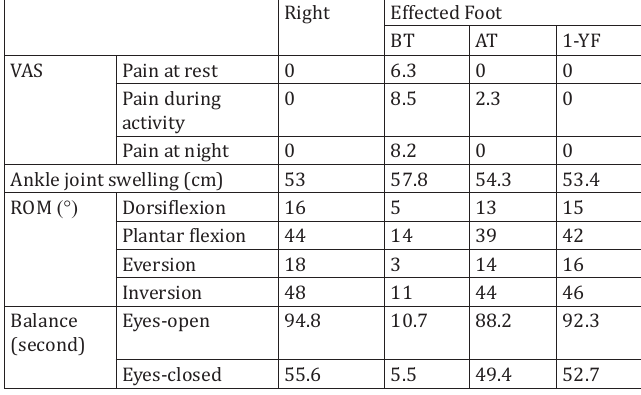
Changes in pain, ankle joint swelling, ROM, and balance parameters in the left ankle